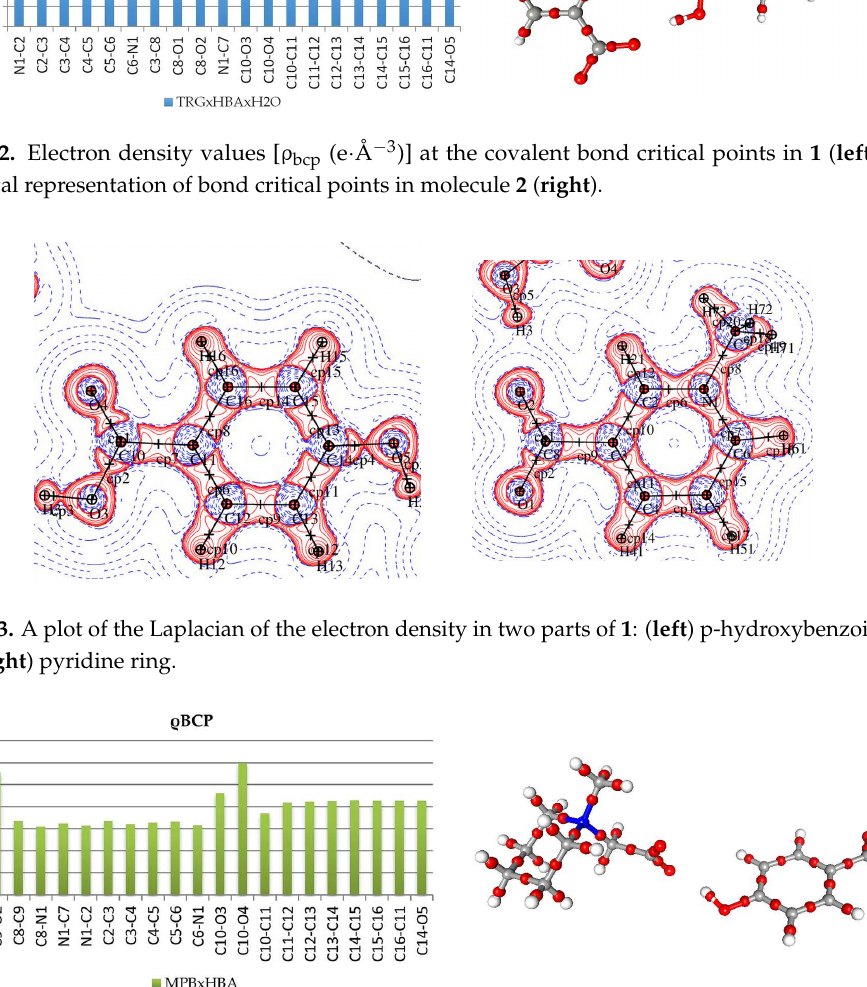
Figure 4. Electron density values [ ρ bcp (e · Å − 3 )] at the covalent bond critical points in 2 ( left ) and graphical representation of bond critical points in molecule 2 ( right